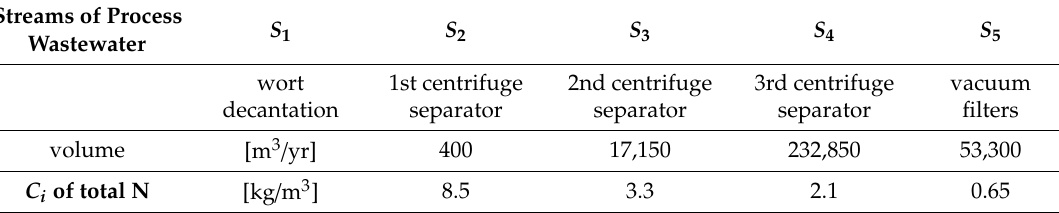
Table 1. Volume and nitrogen of the process